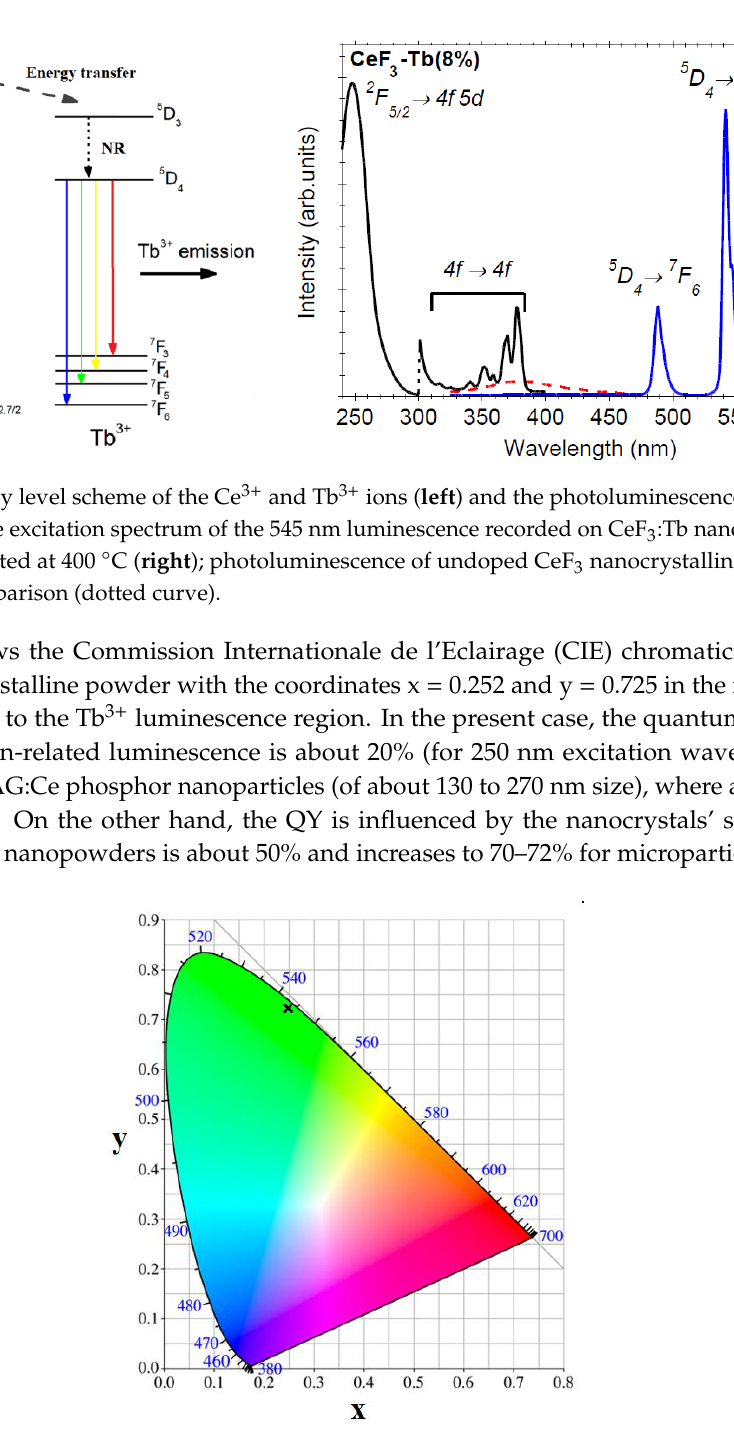
Figure 8. The chromaticity coordinates of the Commission Internationale de l’Eclairage (CIE) chromaticity diagram of CeF 3 :Tb nanocrystalline powder calcinated at 400 °C.